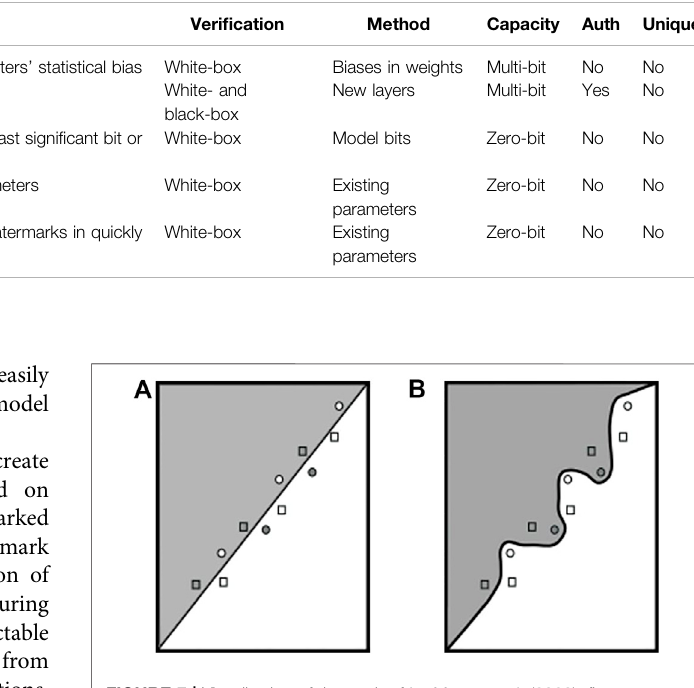
FIGURE 7 | Visualization of the work of Le Merrer et al. (2020), fi gure adaptedfromthestudybyLeMerreretal.(2020).Squaresindicateadversarial examples for the corresponding color, and circles correspond to data points that lie close to the decision boundary but are correctly classi fi ed. Decisionboundary isaltered to correctly classify the adversarial examples. (A) Original decision boundary. (B) After fi